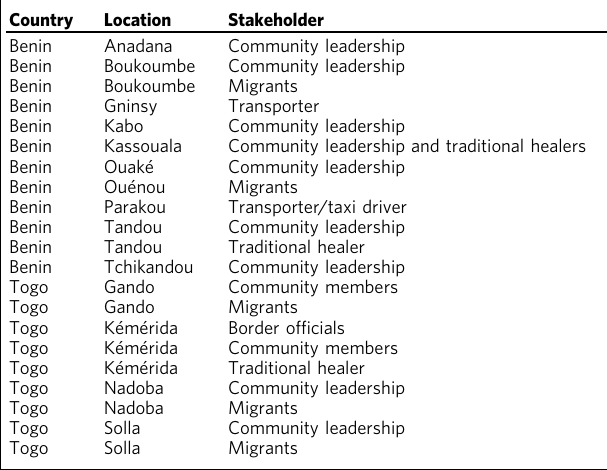
Table 2 PopCAB focus group discussions completed in April 2018, Togo and